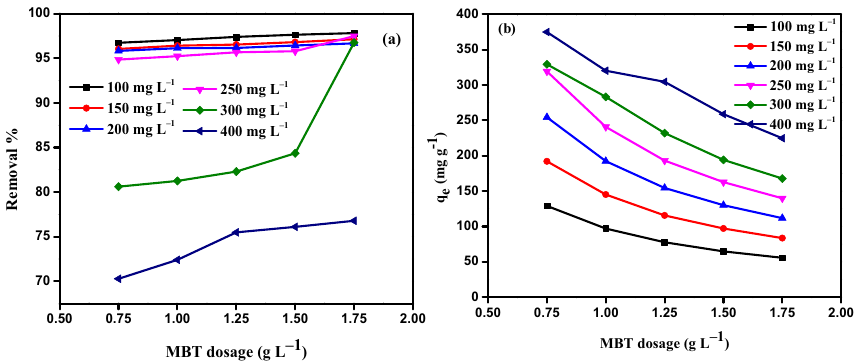
Figure 9. The impact of different MBT doses (0.75–1.75 g L –1 ) of AY11 dye different starting concentration (100–400 mg L –1 ) at RT = 24 ± 2 °C ( a ) on percentage of removal; ( b ) on q e (mg g −1